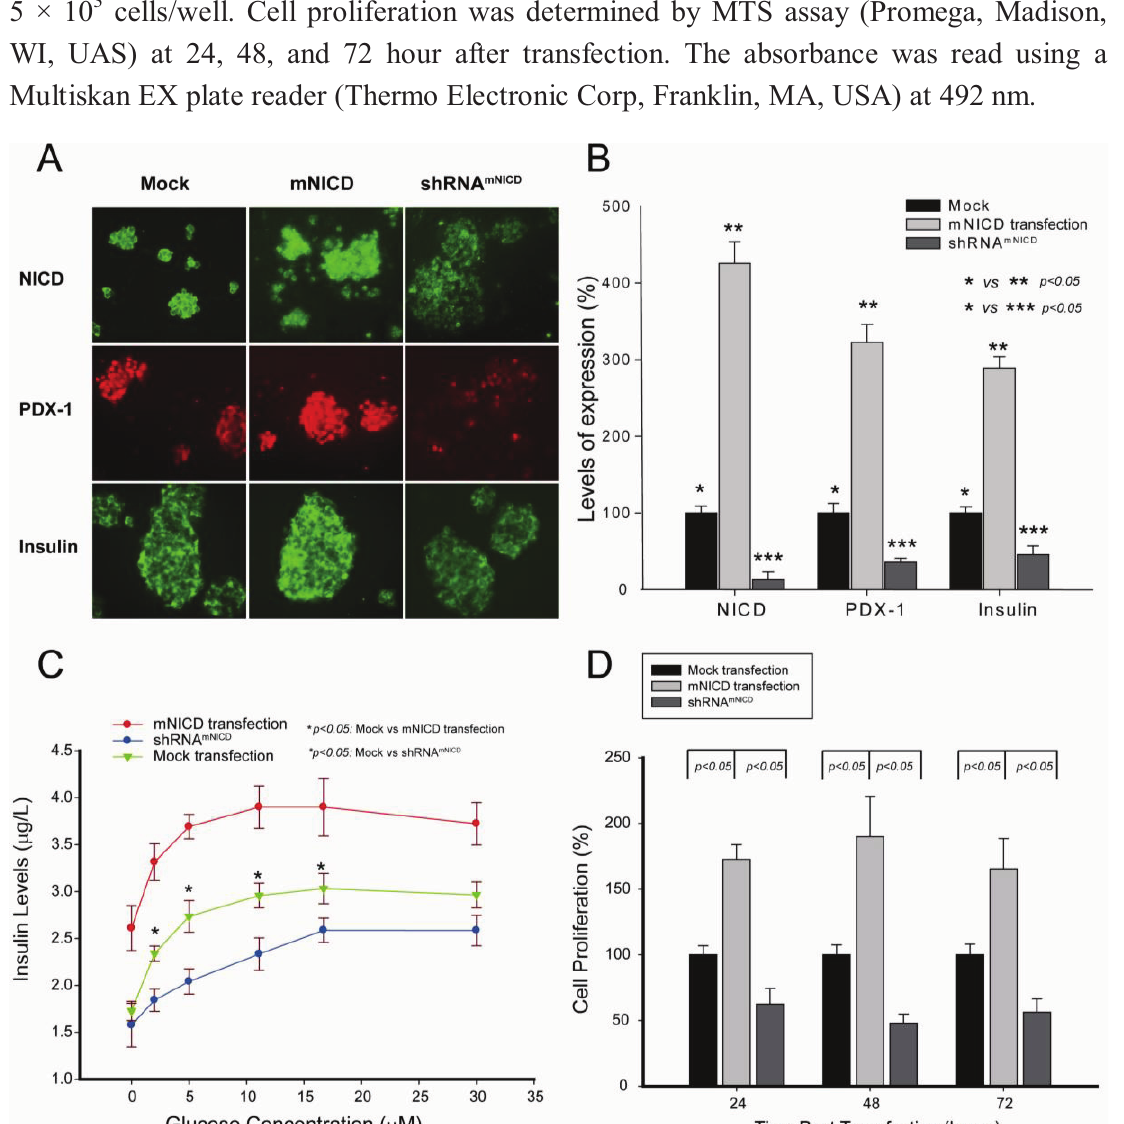
Figure 2. NICD-enhanced PDX-1 expression is accompanied by increased insulin expression/secretion and cell proliferation in β -TC-6 cells. mNICD or shRNA mNICD was transfected into β -TC-6 cells using Lipofectamine 2000. ( A ) Immunohistochemistry analyses were performed using antibodies against NICD, PDX-1 (1:200) or insulin (1:75). Fluorescence was developed using cy3- or FITC-conjugated secondary antibody. Photomicrographs were taken under 100× magnification. ( B ) Immunostaining for the expression of NICD, PDX-1 and insulin was semi-quantified using ImageJ ( (cid:2) indicates p < 0.05 showing significant difference). ( C ) Forty-eight (48) hours after